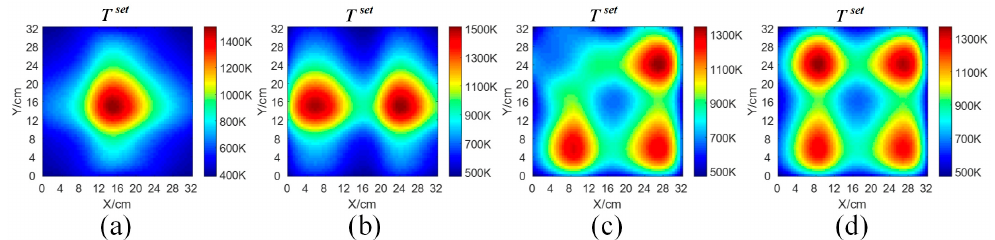
Figure 2 . Four different distributions of temperature phantoms in the simulation. ( a ) One flame, ( b ) Two flames, ( c ) Three flames, and ( d ) Four flames.